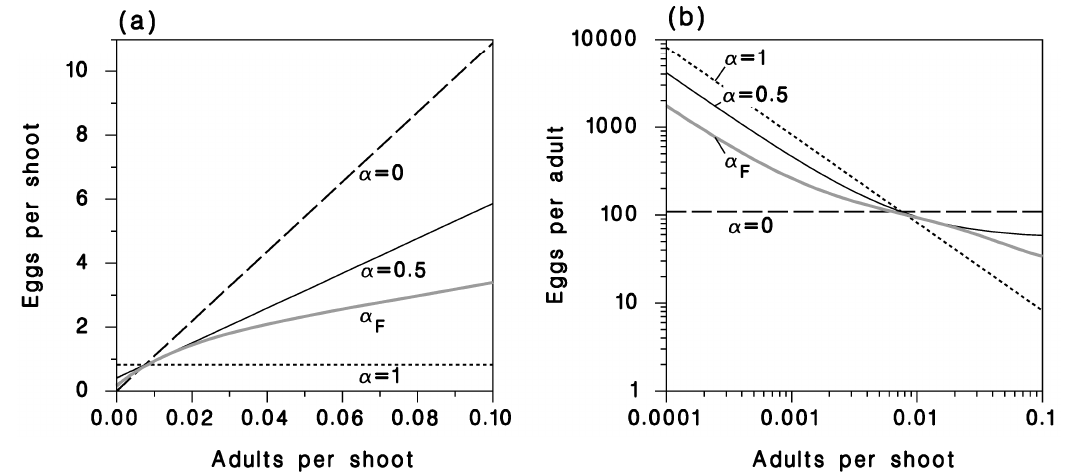
Figure 1. ( a ) Relationship between egg and adult density, illustrating Equations (2) (black lines) and (10) (grey line). ( b ) Relationship between apparent fecundity (eggs/adult) and adult density, illustrating Equations (3) (black lines) and (11) (grey line). Solid line: General case (where α = 0.5). Dashed line: No migration ( α = 0). Dotted line: Panmixis where all moth emigrate ( α = 1). Grey line: Density-dependent emigration (with α = 0.5). In all cases β = 0.5.